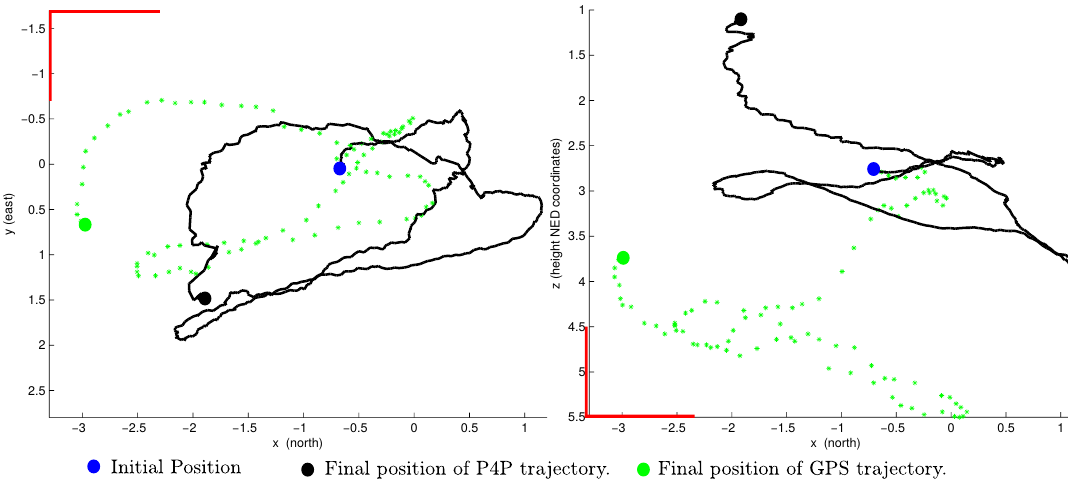
Figure 2. Example of GPS position measurements obtained for a flight performed by the aerial vehicle. Top view ( left plot ) and lateral view ( right plot ) are shown for clarity. Flight trajectory has been computed using the perspective on 4-point (P4P) method described in Section 4. Error drift in GPS readings is noticeable. NED: North, East,